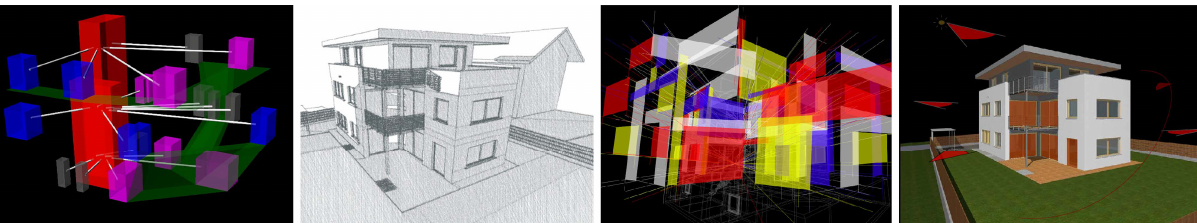
Figure 2. Niederkofler Haus (Plankensteiner & Steger Architects): from the performance schedule to the construction of the digital 3D model (authors: Giovanni Beggio, Alberto Bragagnolo, Giacomo Longo, Roberto